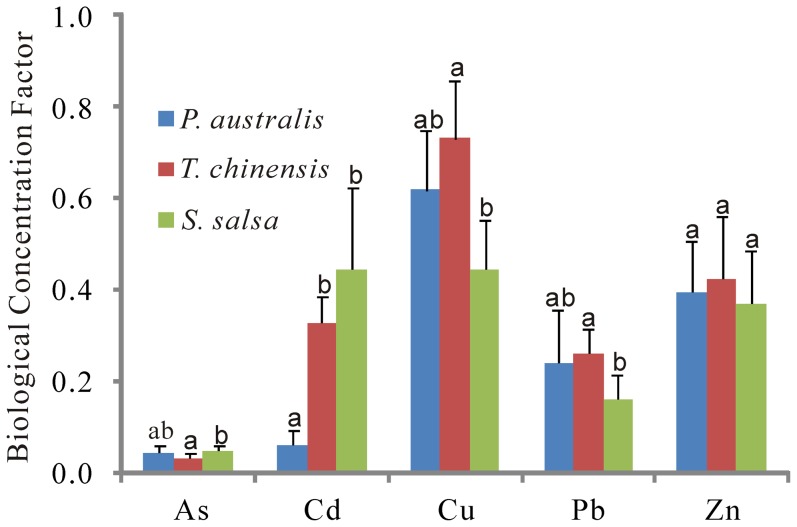
Biological concentration factors of the aboveground parts of plants in each site.
abc Different letters on the error bars represent significant differences (p<0.05).